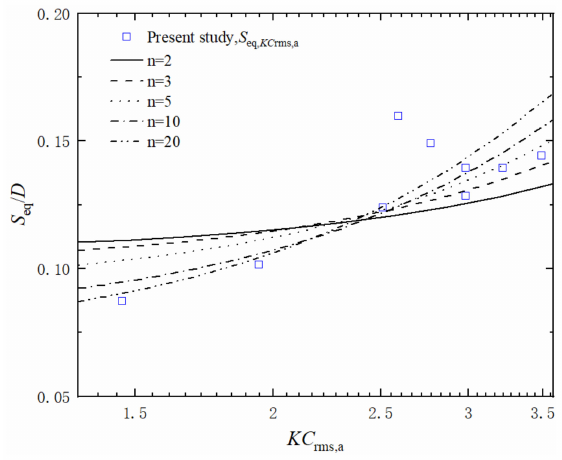
Figure 20. Comparison of S eq between the simulating results and the predicting values by Equation (33).